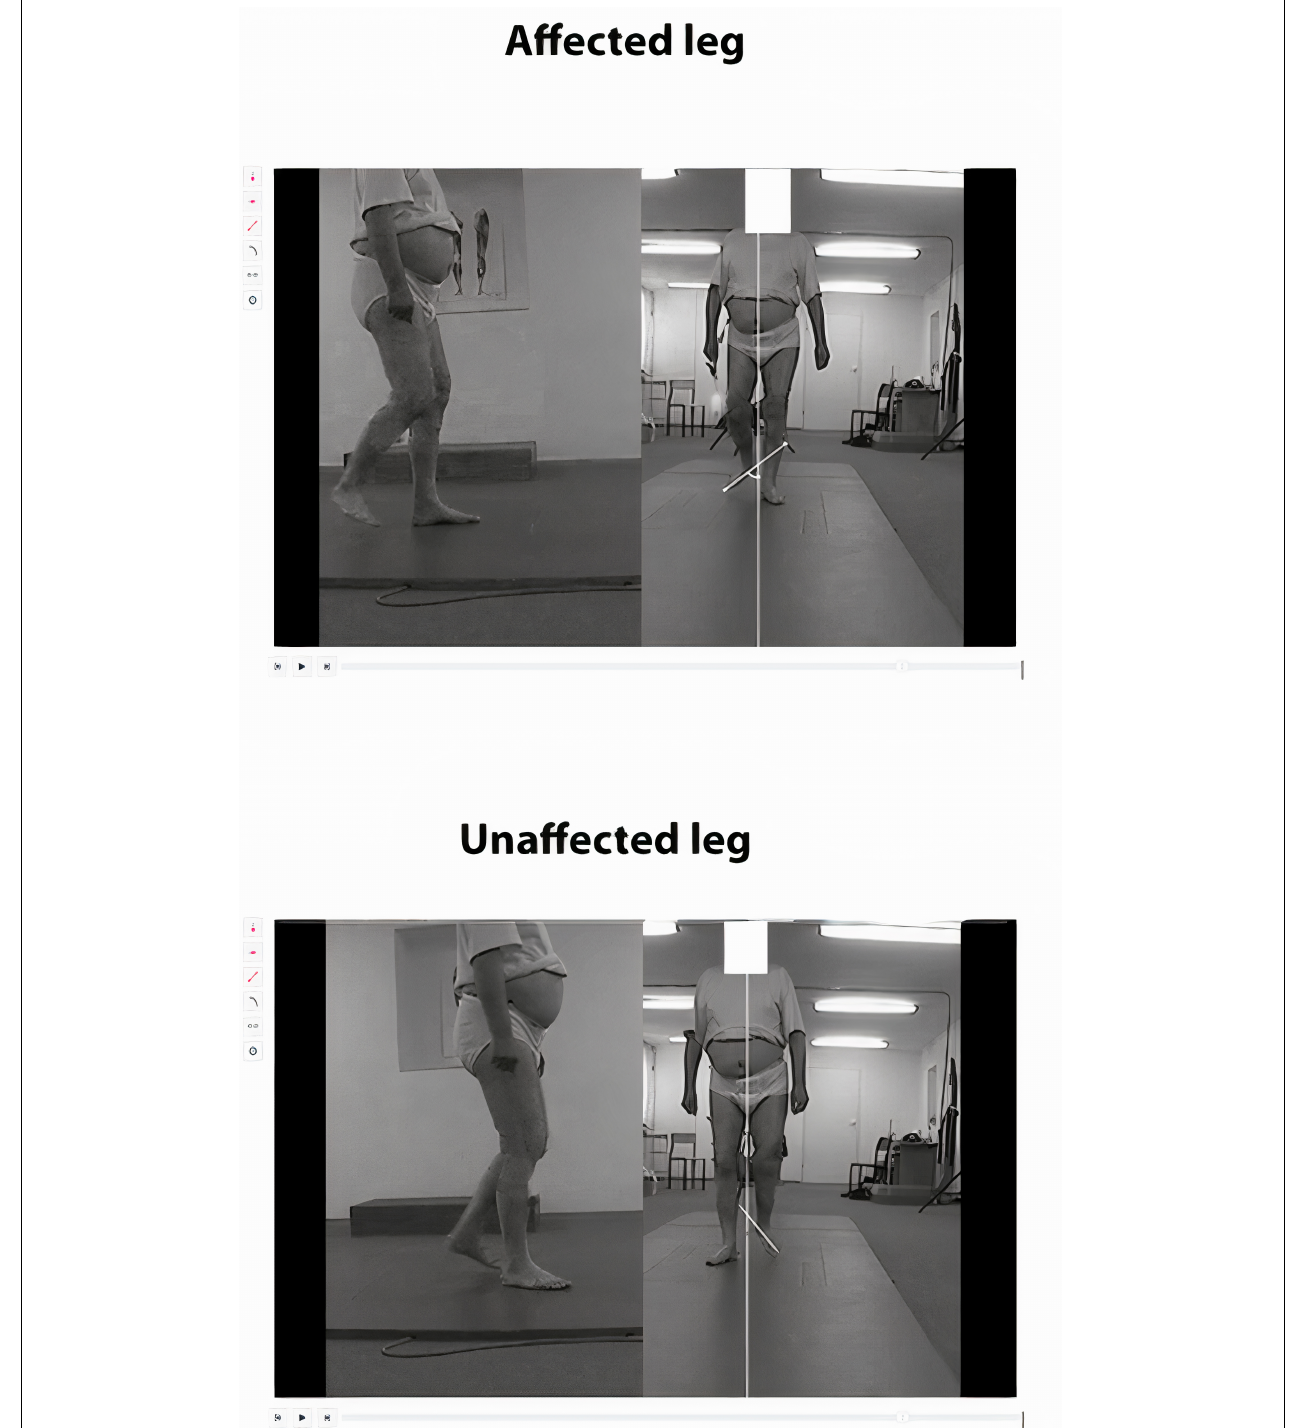
FIGURE 1 | A new application for computerized gait analysis. Subject with right hemiparesis after stroke. Sample assessment of a selected gait parameter in WGS. Swing phase of the affected leg - external rotation during initial swing. On the freeze frame showing the frontal view, we draw two auxiliary straight lines and measure the angle between them. One line shows the direction of gait and runs in the middle of the distance between the medial malleoli, and the other line marks the long axis of the foot (in the middle of the distance between the heads of the first and the fifth metatarsal bones or between the calcaneal tuber and the second toe). The result is compared to the healthy leg. The examiner checks the angles measured and determines the rating (the same angles in both legs, reflecting a normal condition - 1 point; greater angle on the paretic side, but lower than 45 degrees - 2 points; angle exceeding 45 degrees on the paretic side - 3 points).